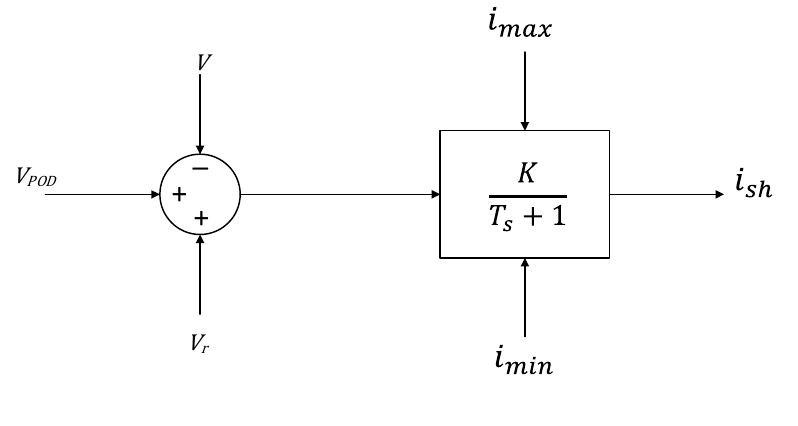
Figure 3. STATCOM model.